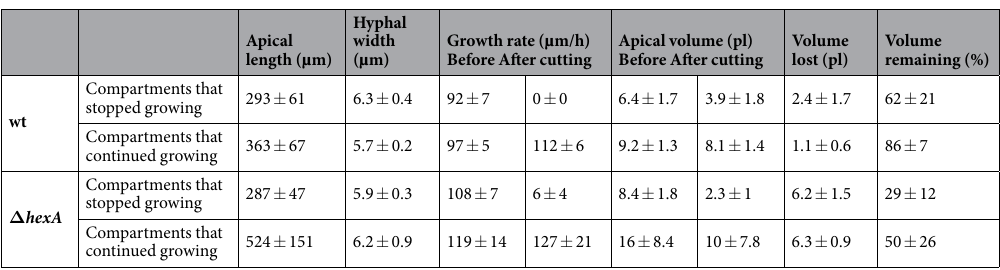
Table 2. Mean length, width, volume, and growth rate ( ± confidence intervals) of apical compartments of wild- type and Δ hexA before and after laser dissection in the 2 nd